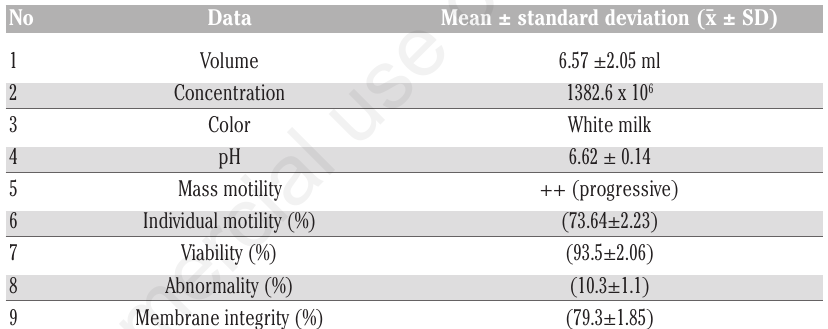
Table 1. Fresh semen quality.